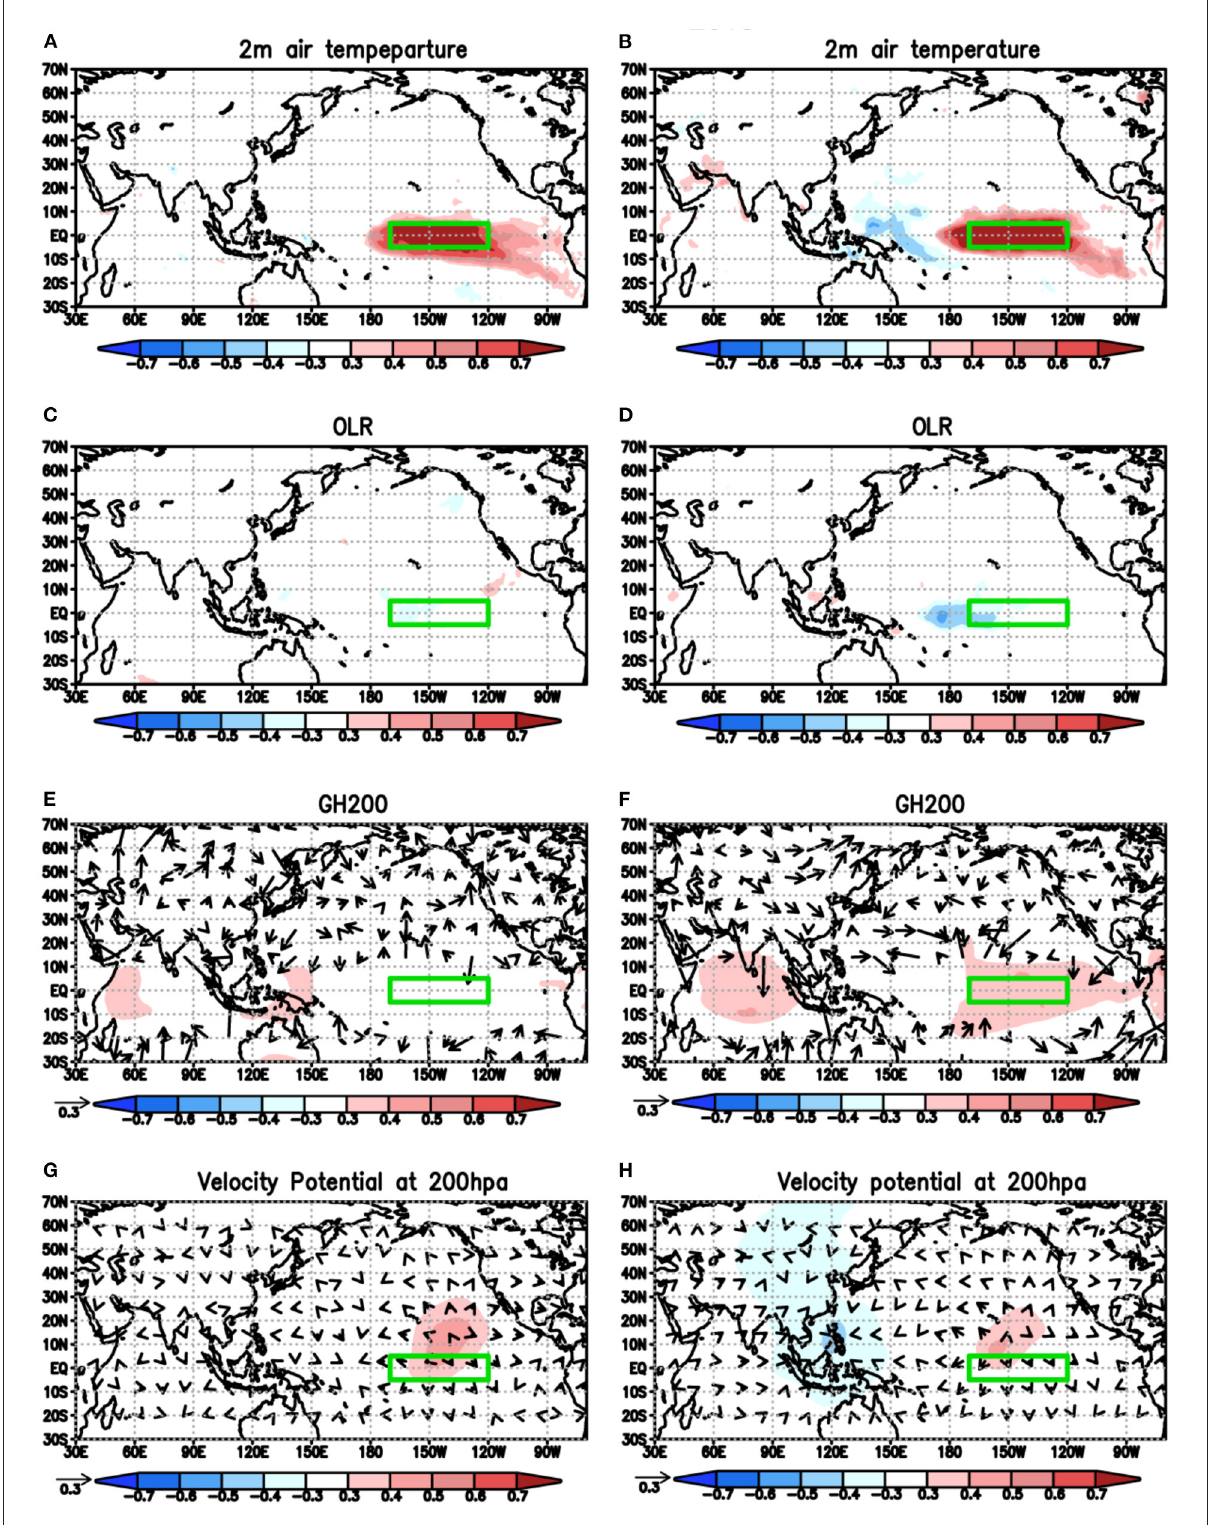
FIGURE4 (A,C,E,G) Same as (Figures 3A,C,E,G), but for co-variability with prediction of Niño3.4 index (SST anomaly averaged in 170 ◦ W − 120 ◦ W, 5 ◦ S − 5 ◦ N) in 1997 (sample size: 108 member). (B,D,F,H) Same as (A,C,E,G) , but for